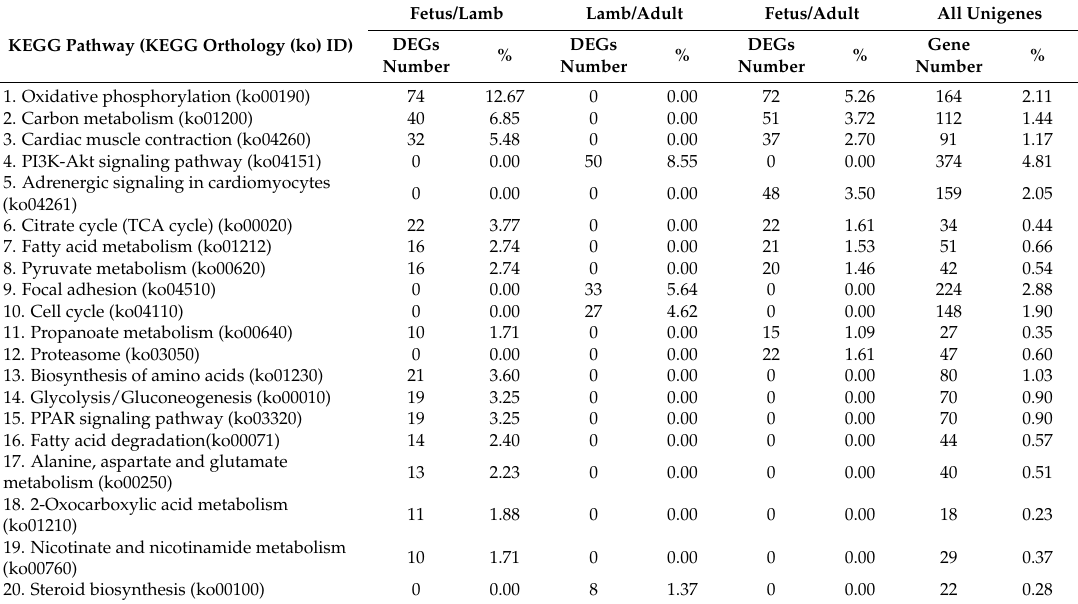
Table 3. Enriched KEGG pathways of DEGs in (control/experiment) fetus/lamb, lamb/adult, and fetus/adult comparisons,